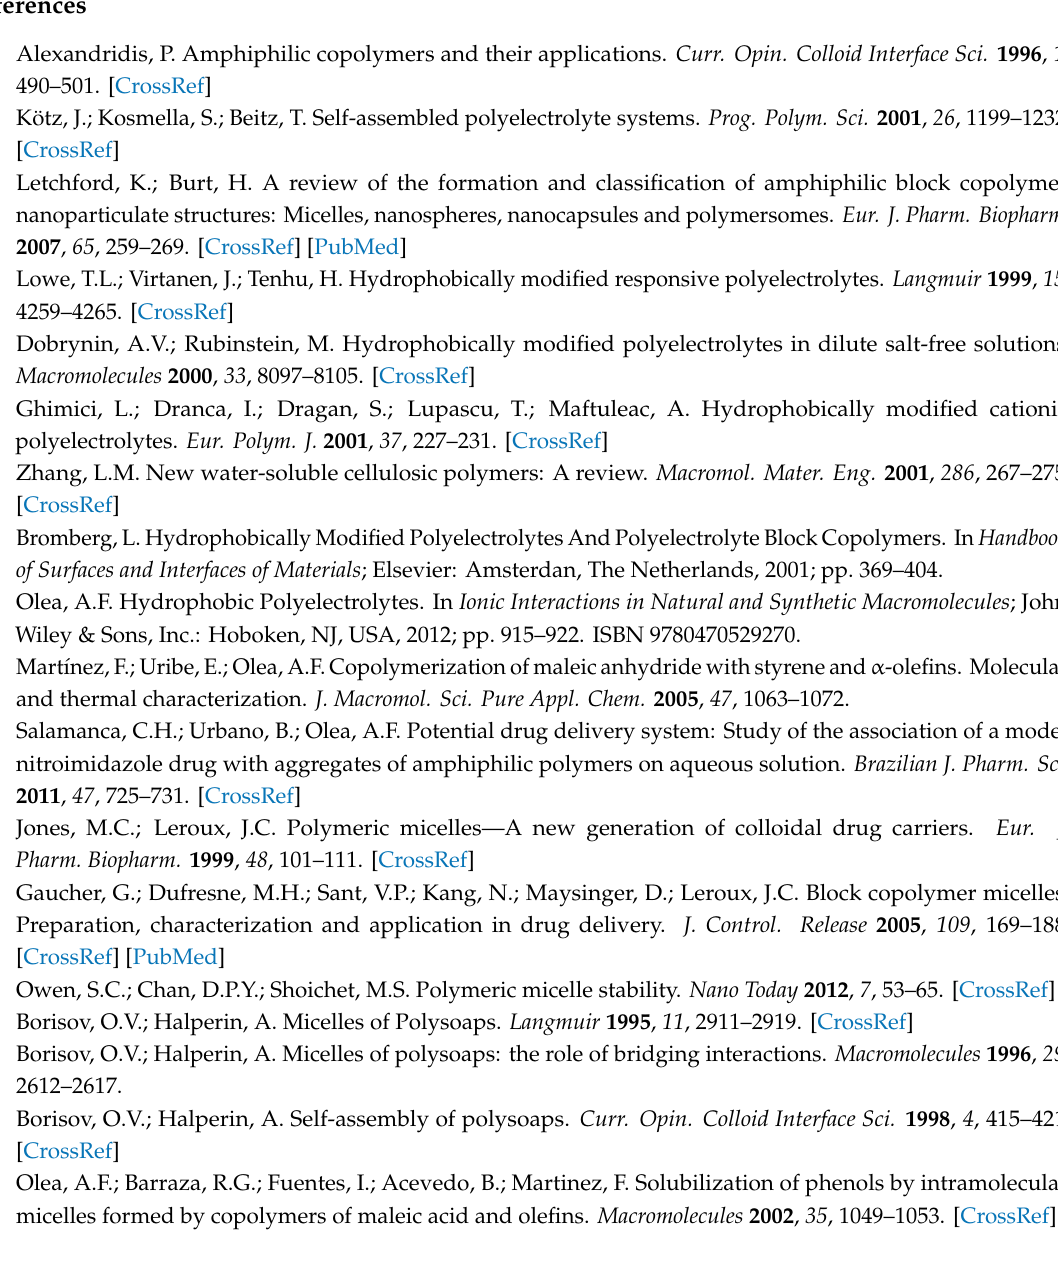
Table S1: Statistical analysis (One Way ANOVA)—Conductivity ( µ S / cm); Table S2: Statistical analysis (One Way ANOVA)—pH; Table S3: Statistical analysis (One Way ANOVA)—Zeta Potential (mV); Table S4: Statistical analysis (One Way ANOVA)—Size (nm); Table S5: Statistical analysis (One Way ANOVA)—AUC of surface tension vs polymer